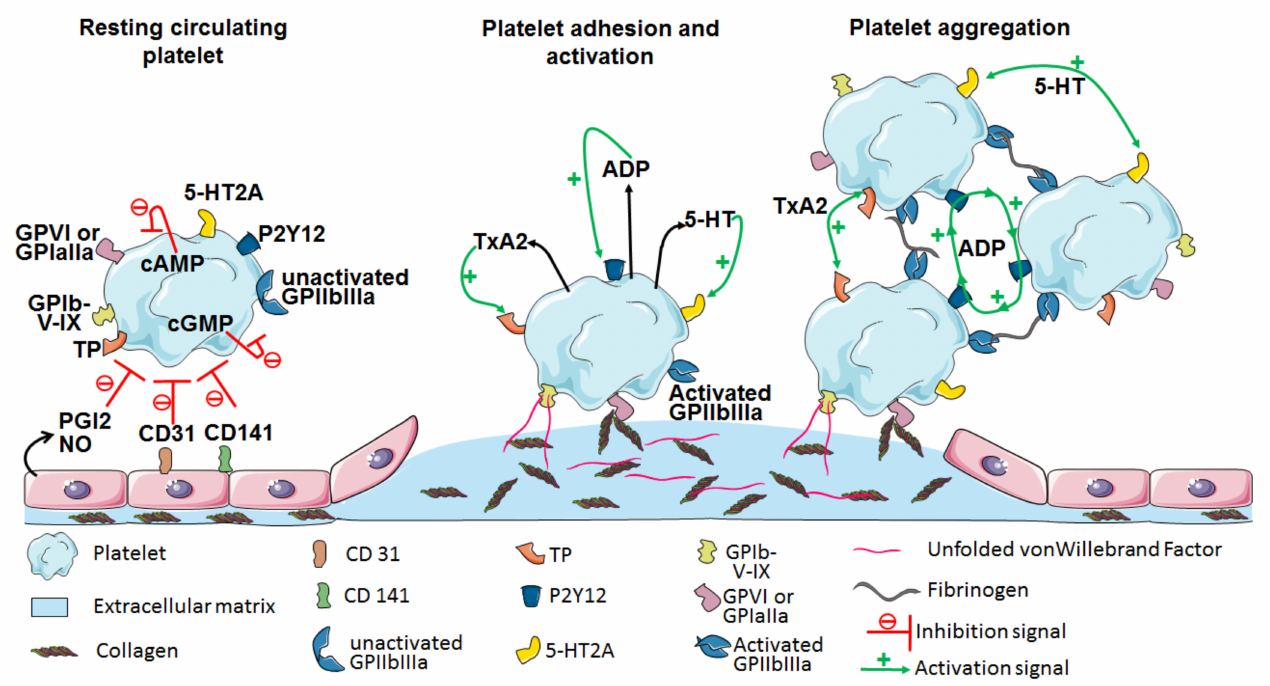
Figure 1. Platelets’ central role in hemostasis. Under resting conditions, platelets circulate in the vessel and are kept in a quiescent state by unaltered endothelial cells that express CD31 (i.e., Platelet endothelial cell adhesion molecule-1, PECAM-1) and CD141 (i.e., thrombomodulin) and secrete prostacyclin (PGI2) and nitric oxide (NO). PGI2 and NO induce the platelet production and intracellular accumulation of cyclic AMP (cAMP) and cyclic GMP (cGMP), respectively, which are both involved in platelet inhibition. Upon vascular disruption and the exposure of the underlying extracellular matrix, platelets bind to unfolded von Willebrand factor (vWF) via their glycoprotein Ib-V-IX (GPIb-V-IX) complex. This initial adhesion is then stabilized by the direct interaction between collagen and platelet GPVI or GPIaIIa. Platelet adhesion can also be stabilized indirectly through the action of the vWF bound to collagen, which is then sensed by the GPIb-V-IX complex. Platelet adhesion then triggers multiple signaling pathways, resulting in platelet activation through the degranulation of numerous factors, including adenosine diphosphate (ADP), thromboxane A2 (TxA2) and serotonin (5-HT), through the P2Y12, TP and 5-HT2A receptors, respectively. Aside from degranulation, GPIIbIIIa undergoes a conformational change to its active form and binds to fibrinogen. The platelet secretion of hemostatic factors and their binding to fibrinogen fuel the autocrine activation loop of platelets, leading to aggregation and coagulation